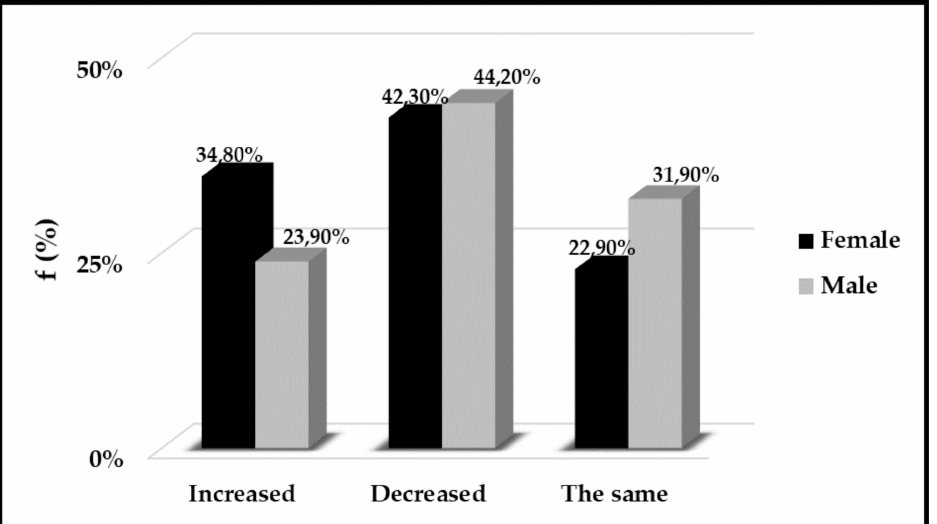
Figure 3. Physical activity during quarantine. On the y-axis we reported the frequency as a percentage (%) to the total population and on the x axis the variation of physical activity habits.